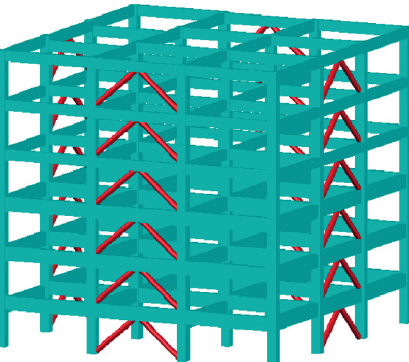
Figure 2: 3D view of the reinforced concrete building with BRBs (model RC-BRB6).